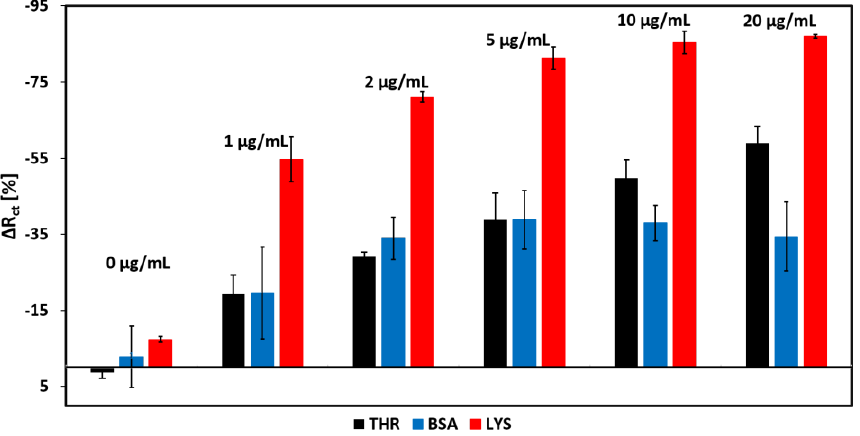
Figure 12. Selectivity of the aptamer biosensor to lysozyme against other proteins such as thrombin and bovine serum albumin for different